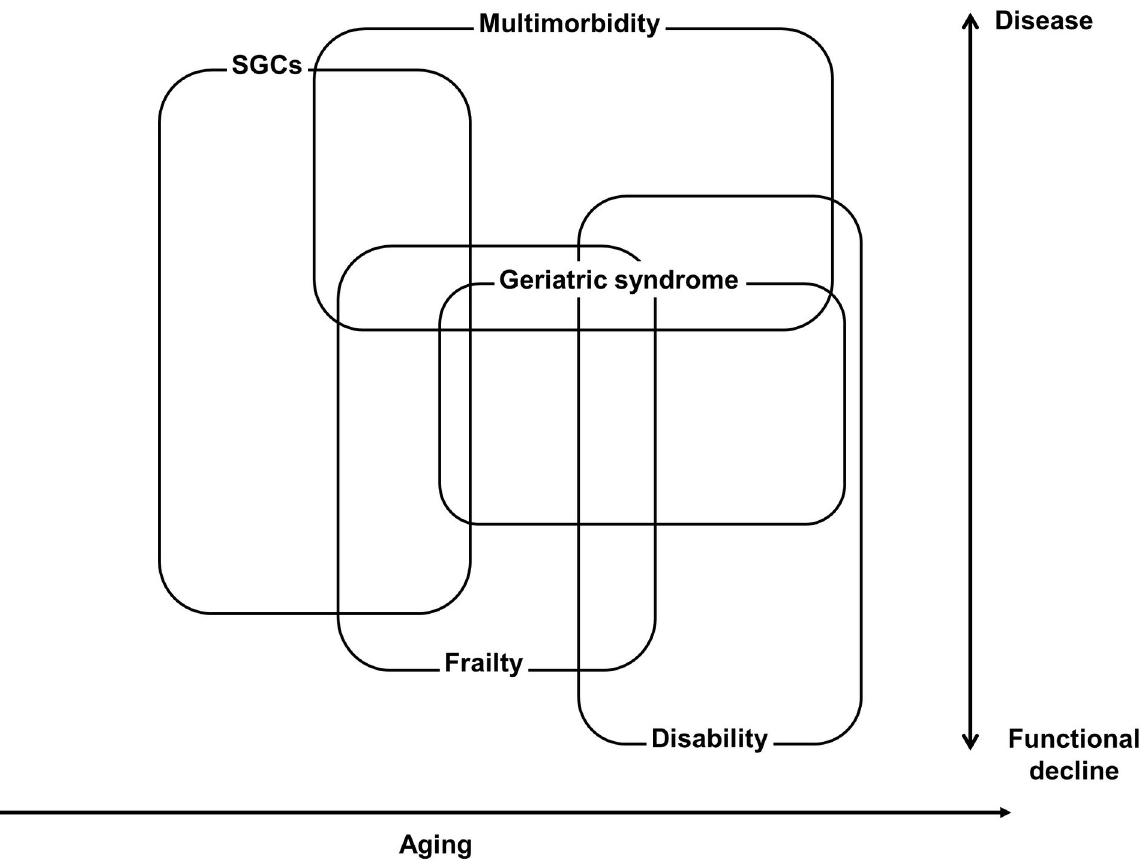
Fig 2. Hypothetical scheme of the relationships among SGCs, frailty, multimorbidity, geriatric syndrome, and disability. SGCs: subjective geriatric complaints.